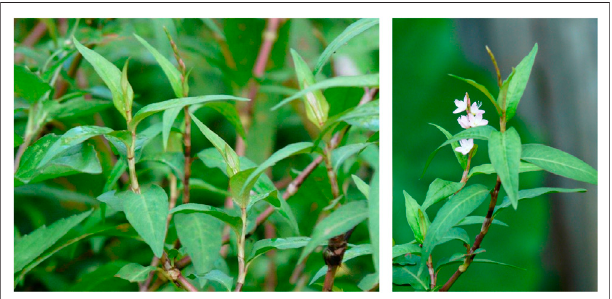
FIGURE2| Characteristics of P.odoratum (adapted fromPeterdehart3, 2021 and Kabilawan,